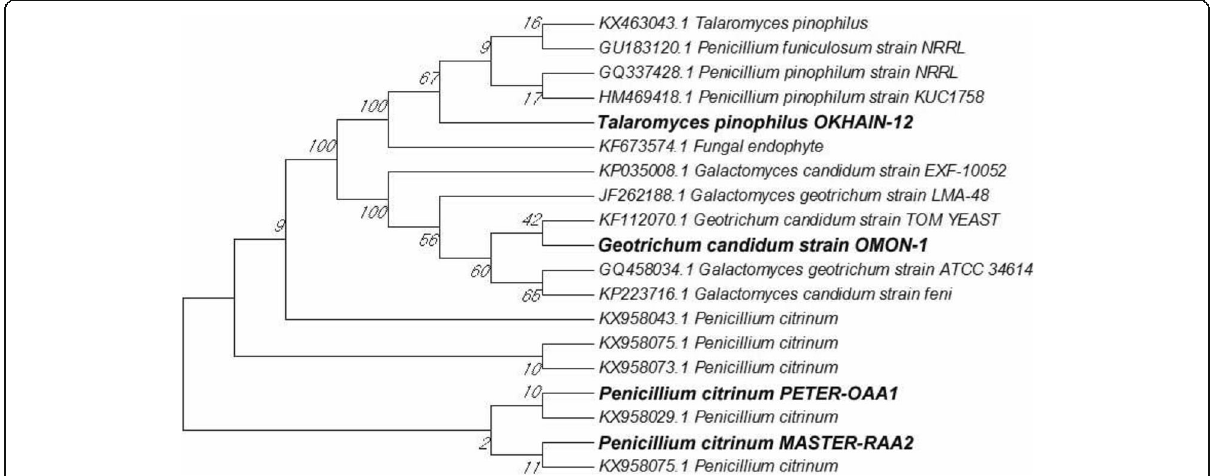
Fig. 2 Phylogenetic tree describing the evolutionary relationship between antibiotic-producing strains and selected species from NCBI BLAST database